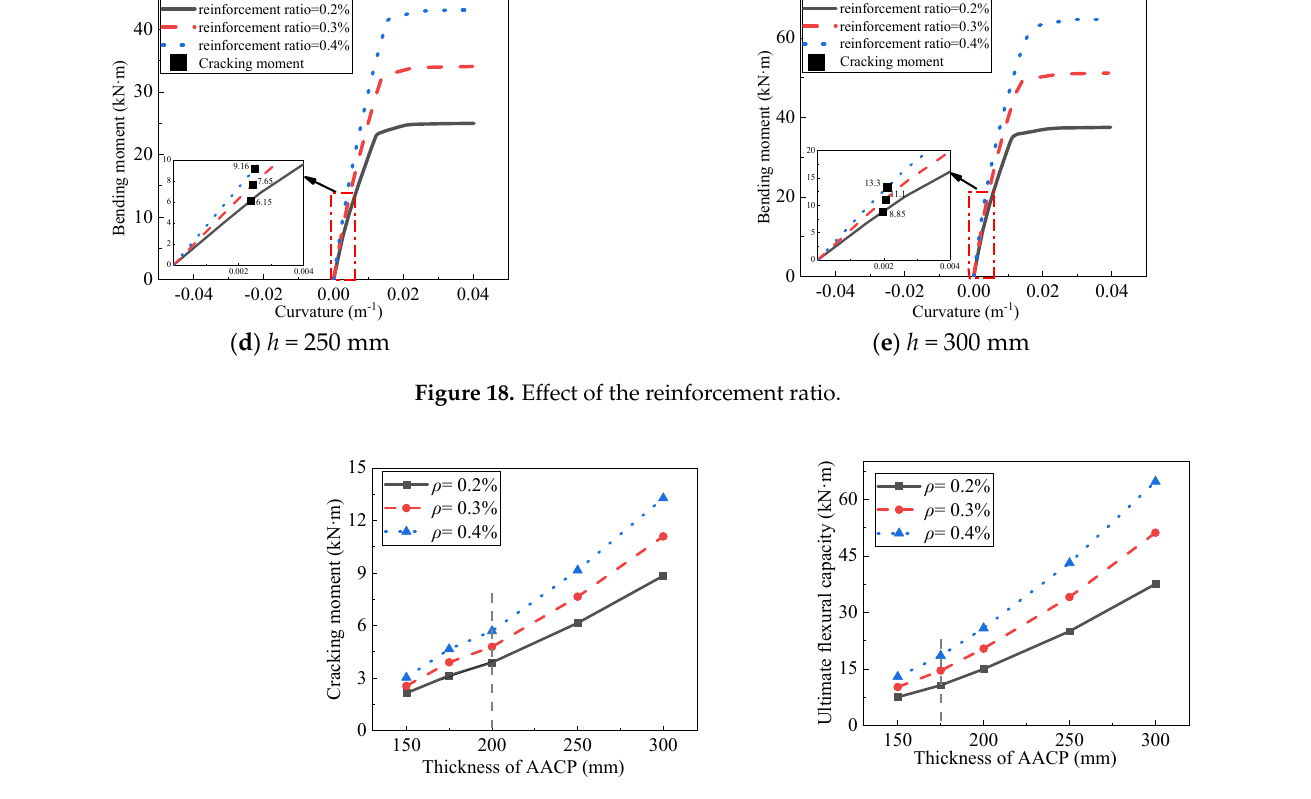
Figure 19. Comparison of the cracking moment (and ultimate flexural capacity) among the AACPs with different